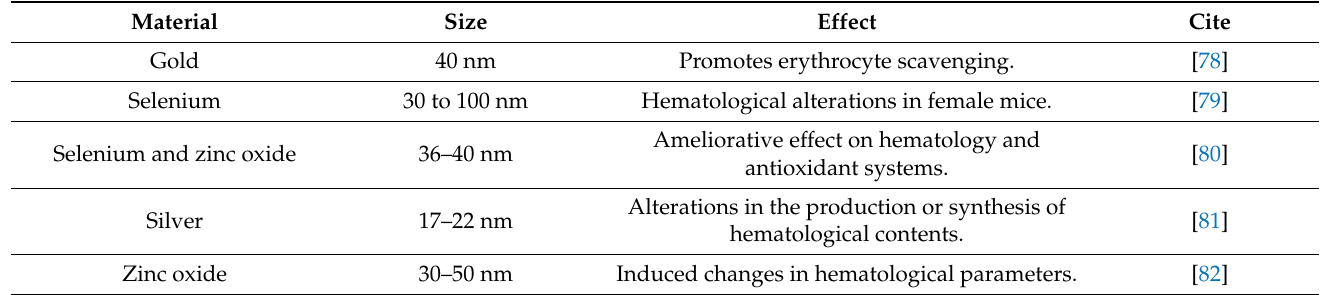
Table 5. Hematoxicity associated with inorganic